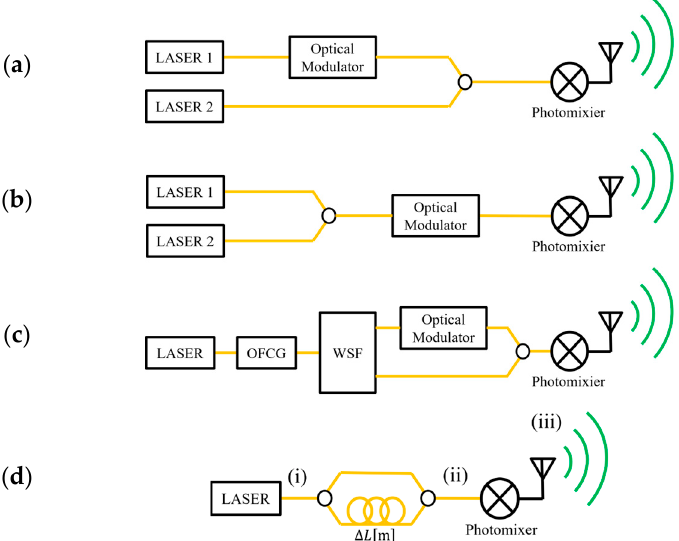
Figure 1. Diagrams of conventional terahertz wave generation and modulation systems based on photomixing technologies, ( a ) with two lasers and an optical modulator before an optical coupler, ( b ) with two lasers and an optical modulator after an optical coupler, and ( c ) with a single laser using an optical frequency comb generator. ( d ) Diagram of proposed terahertz wave generation and modulation system based on photomixing technologies with a single wavelength-tunable laser.